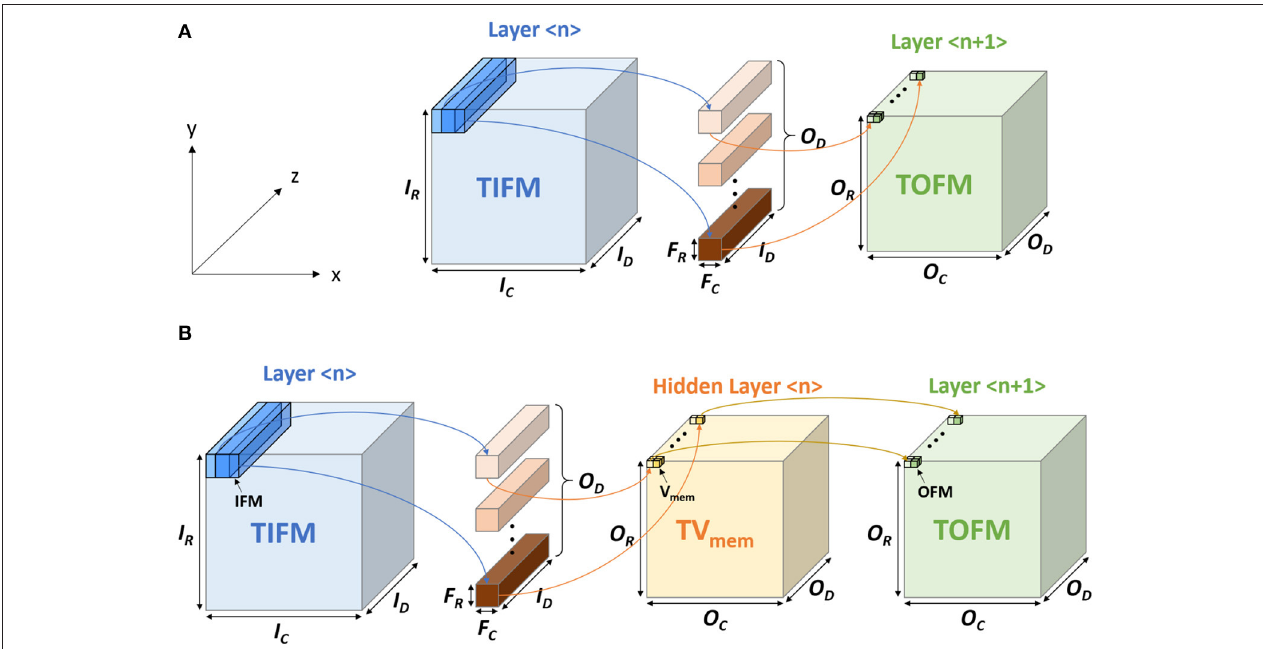
FIGURE 1 | The computational model in (A) convolutional neural network (CNN) and the (B) convolutional neural network within spiking neural network